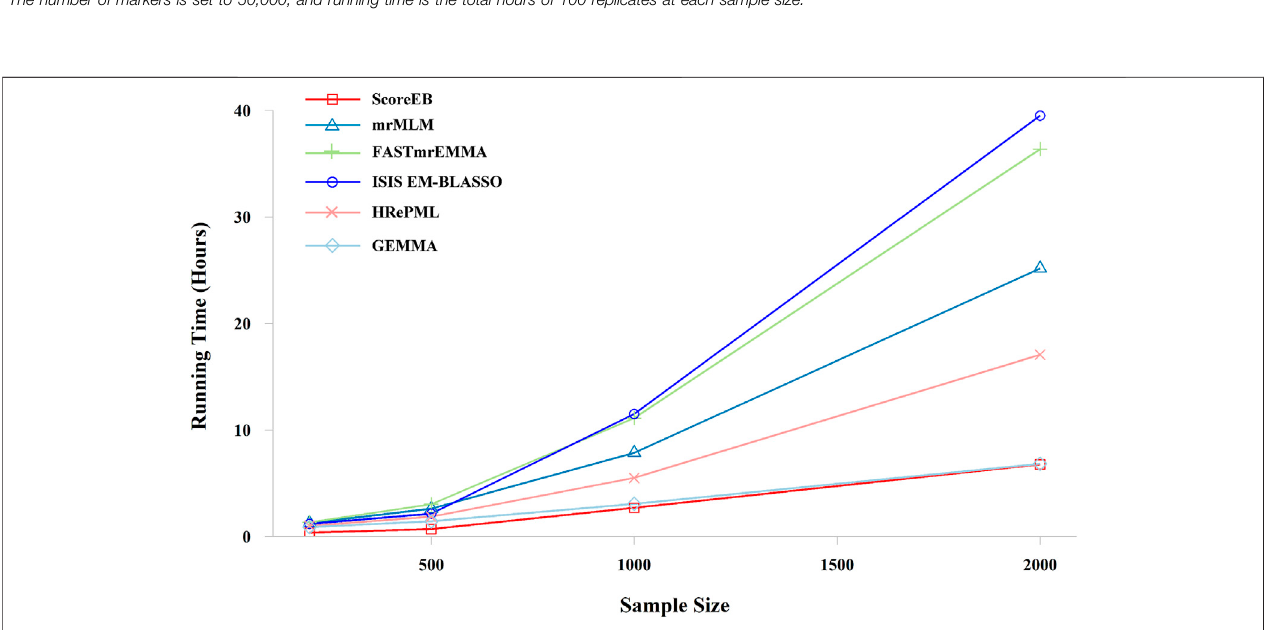
Frontiers in Genetics |